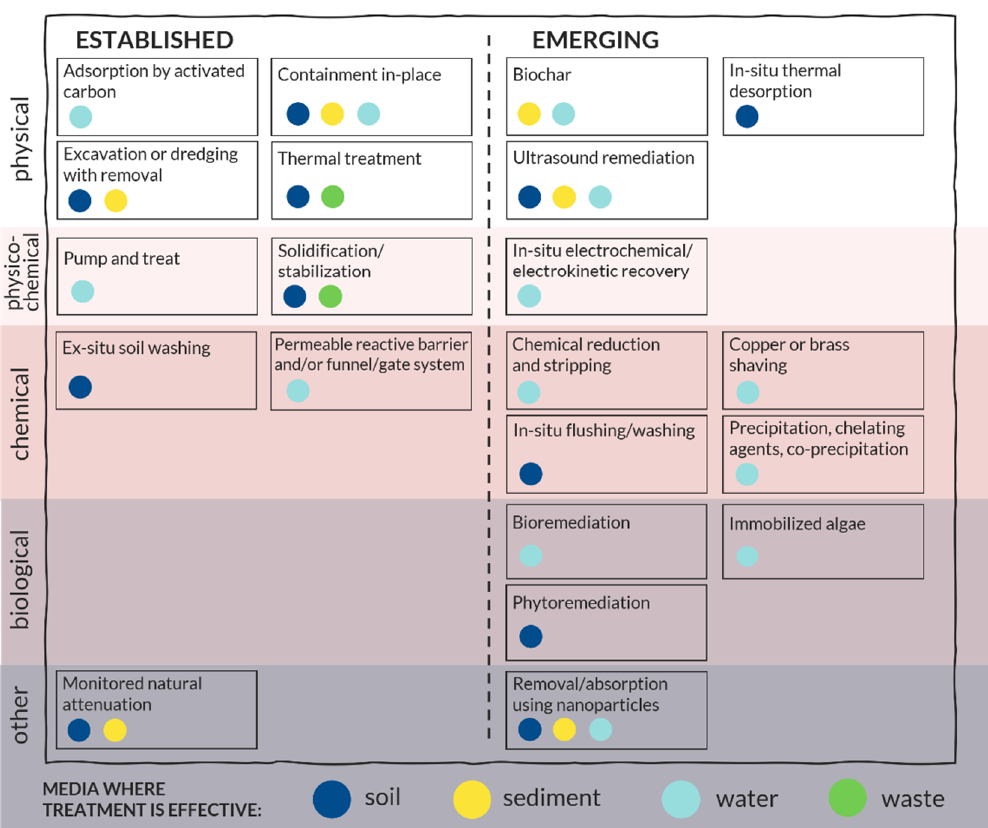
Figure 3. Established and emerging remediation technologies for Hg-contaminated zones.